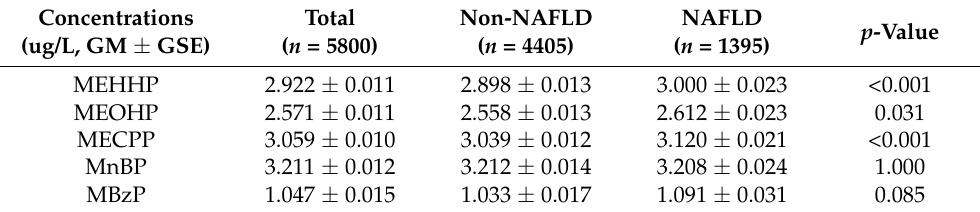
Table 2. Urinary phthalates levels according to hepatic steatosis index score.